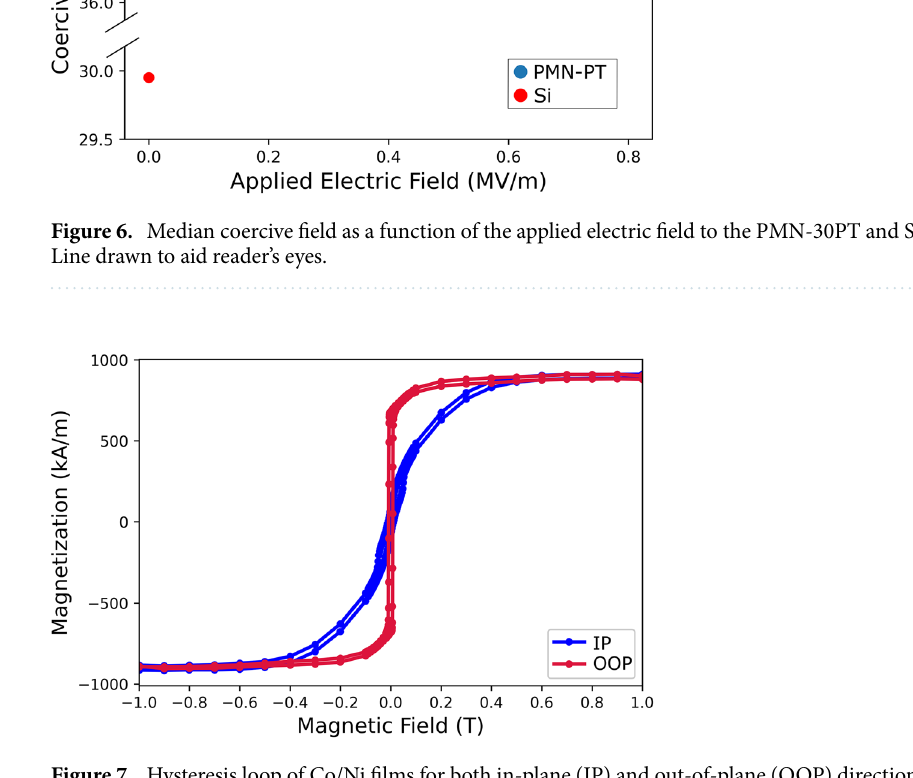
Figure 7. Hysteresis loop of Co/Ni films for both in-plane (IP) and out-of-plane (OOP)